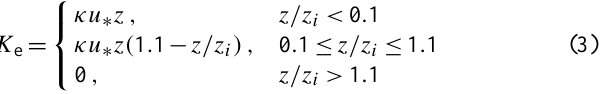
G´omez Mart´ın et al. (2007); Saiz-Lopez et al. (2008) G´omez Mart´ın et al. (2007); Saiz-Lopez et al. (2008) Saunders and Plane (2005); Saiz-Lopez et al. (2008) Saunders and Plane (2005); Saiz-Lopez et al. (2008) Saunders and Plane (2005); Saiz-Lopez et al. (2008) Kaltsoyannis and Plane (2008) Kaltsoyannis and Plane (2008) estimated by Mahajan et al. (2009b) estimated by Mahajan et al. (2009b) estimated by Mahajan et al.